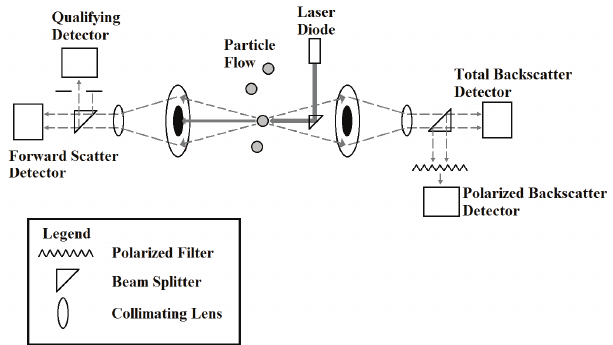
Fig. 1. Schematic of the CASPOL instrument (DMT Manual, 2011).